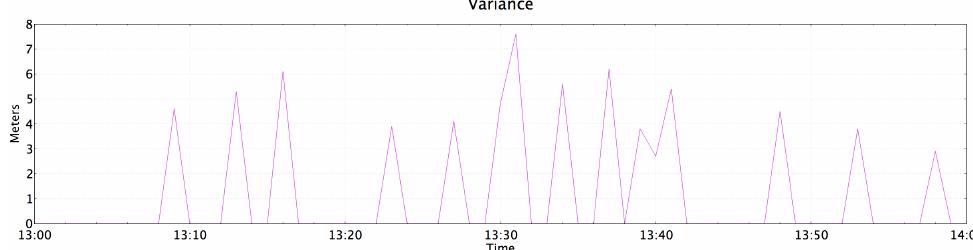
Figure 19. Variance in meters between real location and the location saved.